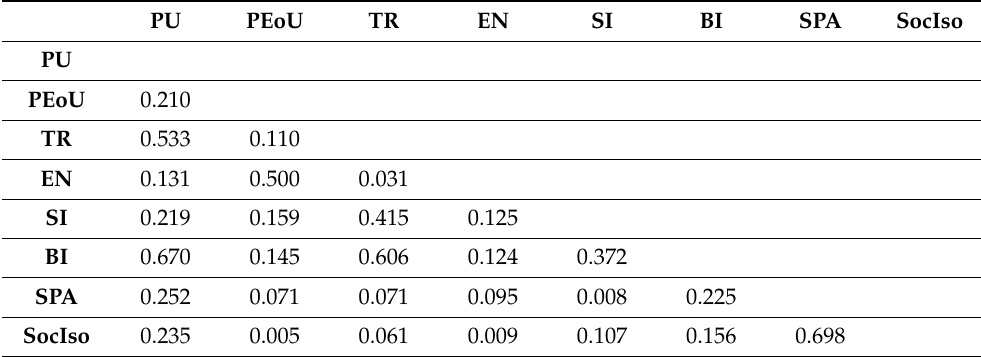
Table 9. HTMT criterion